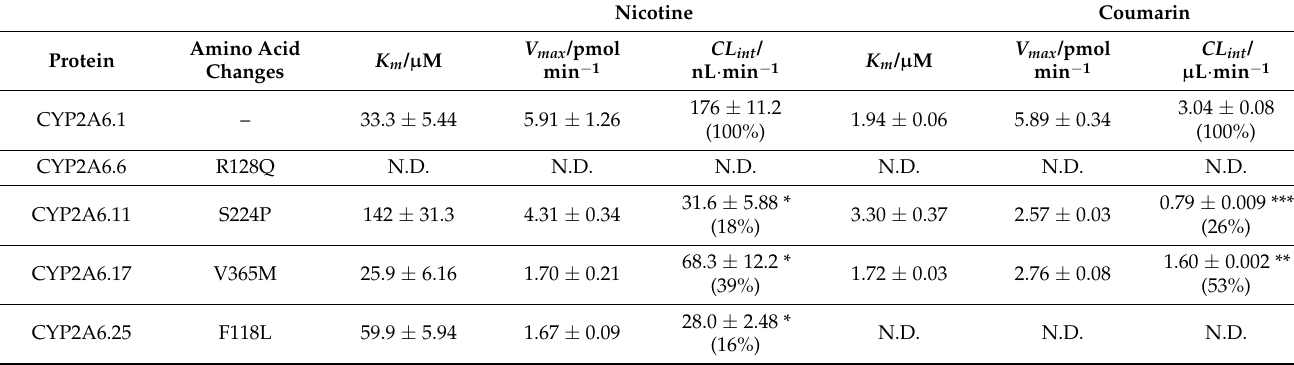
Table 1. Kinetic parameters for the wild type (CYP2A6.1) and mutants used in this study. Kinetic parameters for nicotine and coumarin are shown. The percentages of intrinsic clearances ( CL int ) are compared with CYP2A6.1 CL int. [22]. Nicotine Coumarin